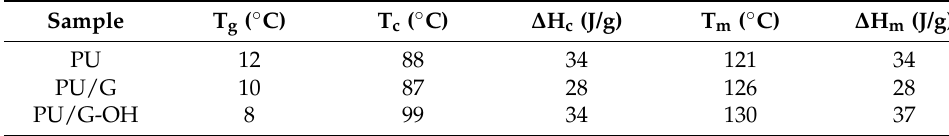
Figure 6. WAXD patterns of: HSAG ( a ), G-OH (b), PU ( c ), PU/G ( d ), and PU/G-OH ( e ). Table 3. T g , T m , and ∆ H m for composites of Table 1 1